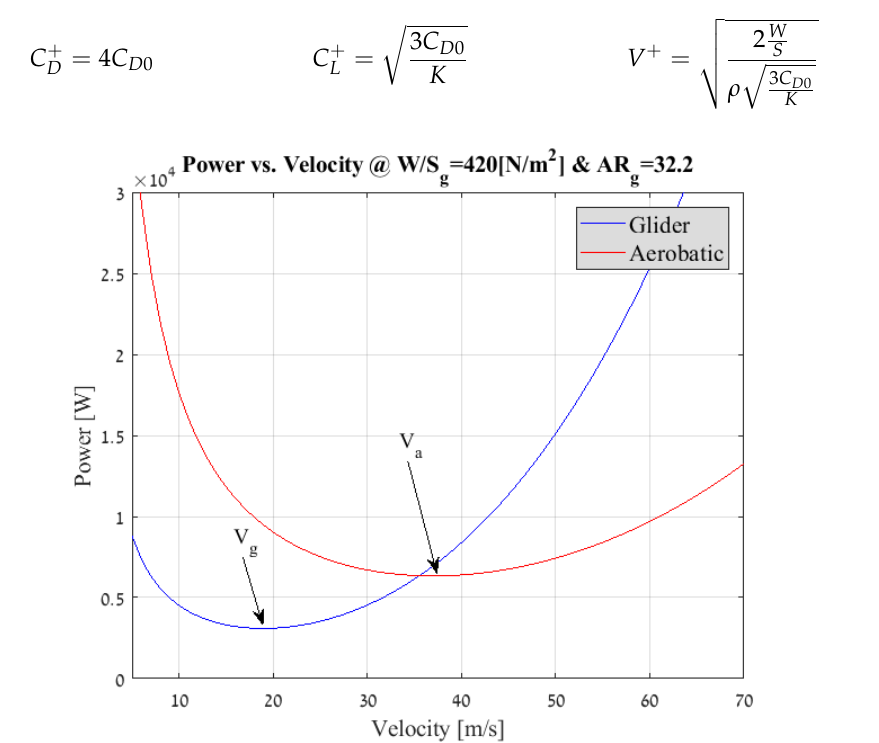
Figure 5. Required power vs. velocity for the glider and aerobatic configurations at specific wing load and aspect